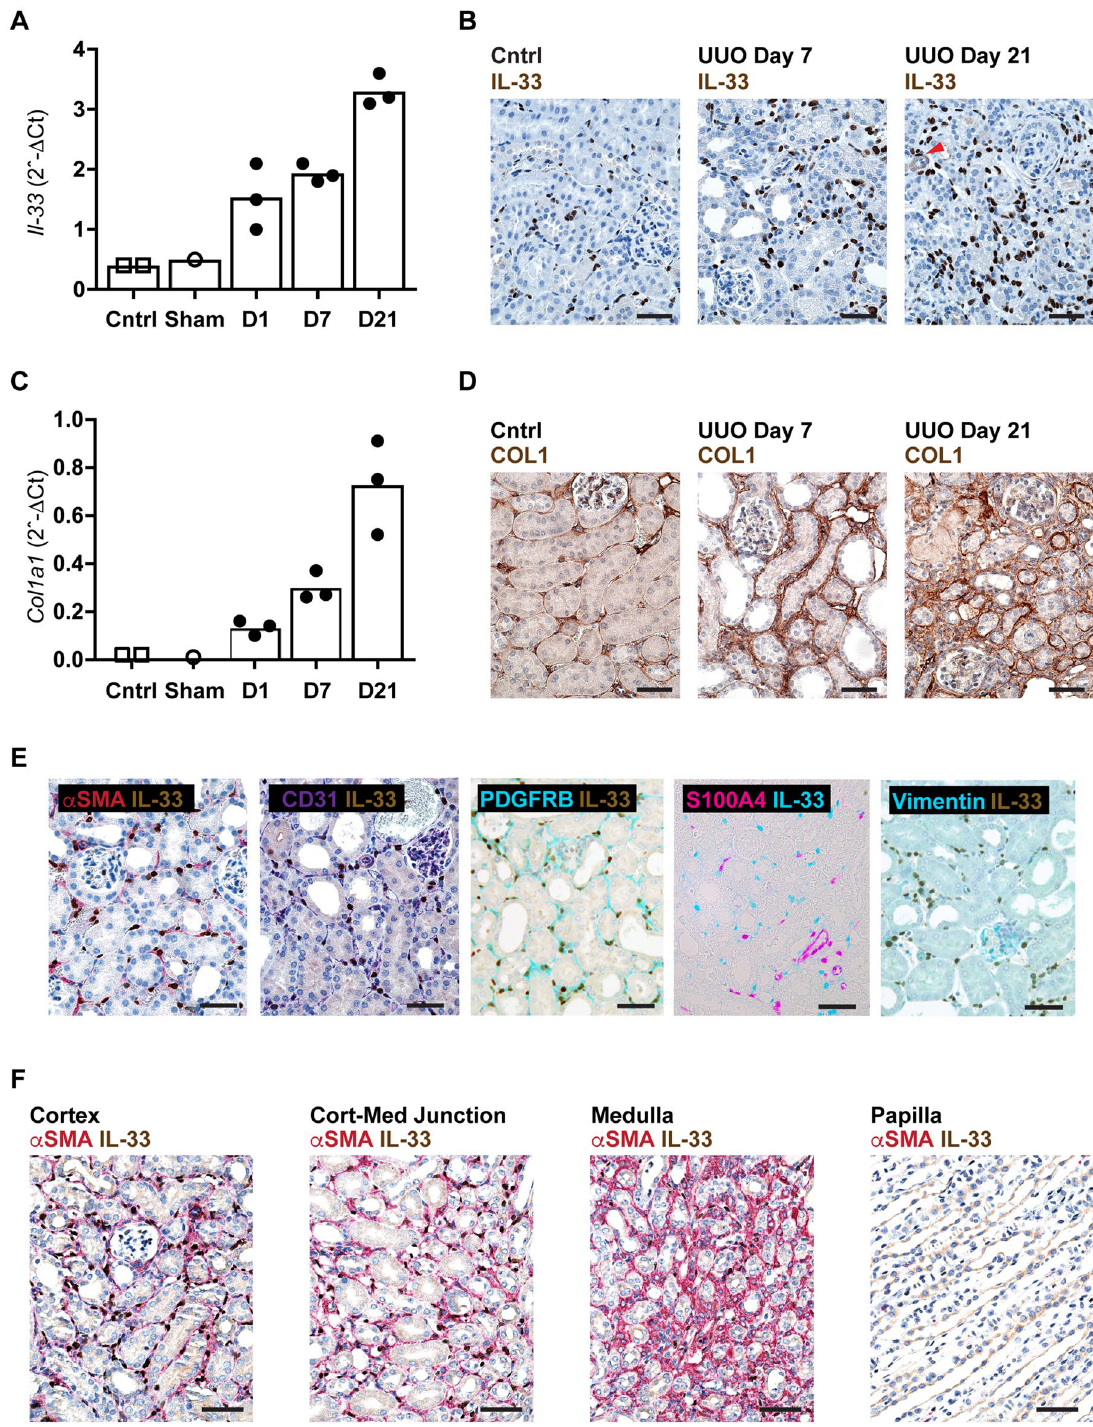
Figure 1. Unilateral ureteral obstruction induces IL-33 expression in mouse kidney. ( A , C ) Relative expression of Il33 and Col1a1 in kidneys from healthy control mice (n = 2) or mice subjected to sham-operation (n = 1) or UUO after 1, 7, or 21 days (n = 3 at each time point). Transcription levels were quantified as detailed in Materials and Methods by qRT-PCR. Data points represent individual mice. ( B , D – F ) Representative photomicrographs of tissue sections stained for IL-33 [brown signal in ( B ) and ( F ), brown or teal signal in ( E )], COL1 (brown signal in panel D) , aSMA (red, E , F ), CD31 (purple, E ), PDGFRB (teal, E ), Vimentin (teal, E ) and S100A4 (purple, E ) in kidneys from healthy control mice or mice subjected to UUO 2 days ( E ), 7 days ( B , D , F ) or 21 days ( B , D ) previously. Panel ( F ) shows different areas of the kidney as labelled. Scale bars = 20